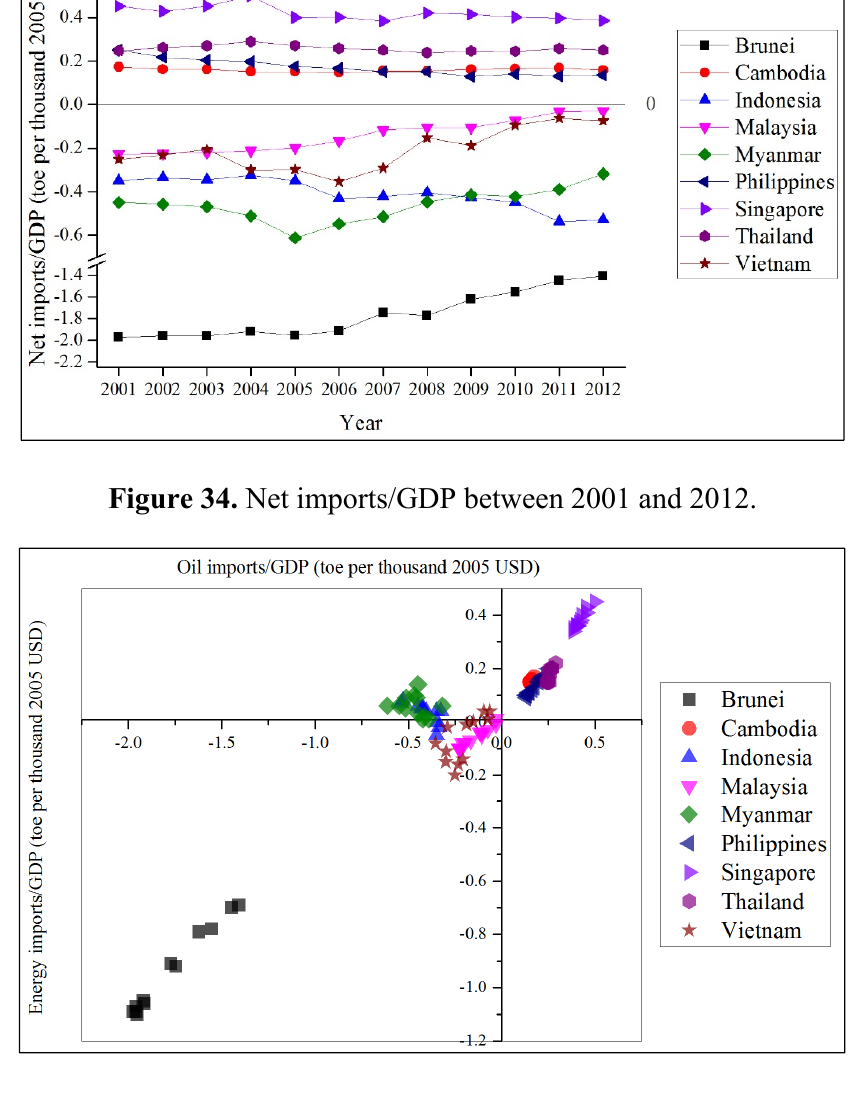
Figure 35. Net imports/GDP and oil imports/GDP